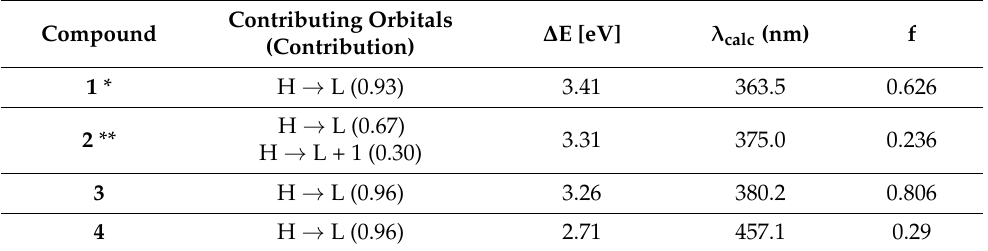
* Data taken from [21] ** Data taken from [22].